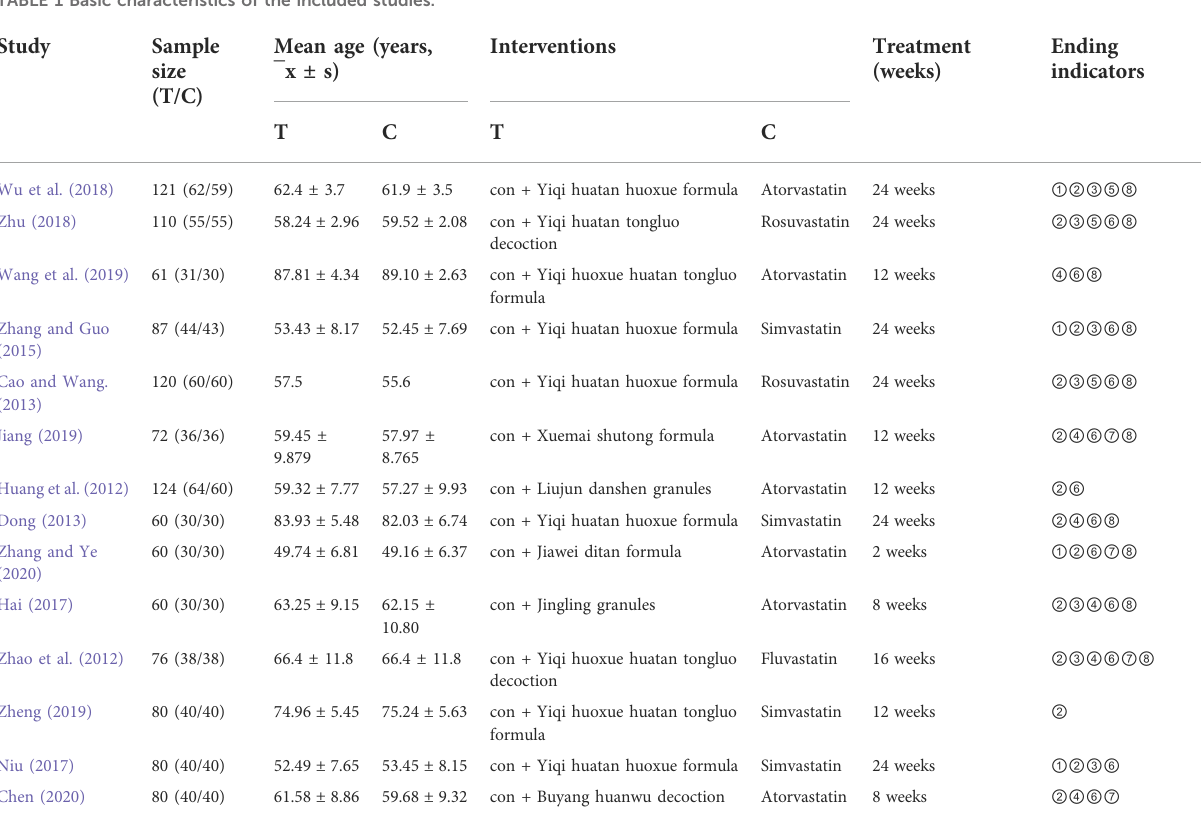
TABLE 1 Basic characteristics of the included